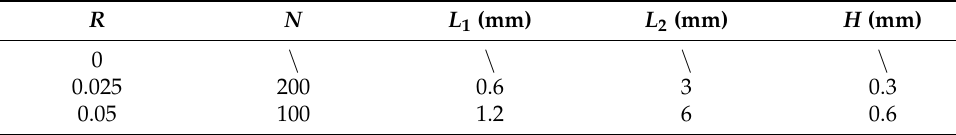
Figure 3. Steel plates with different roughness levels. Table 3. Different roughness levels of steel plates.